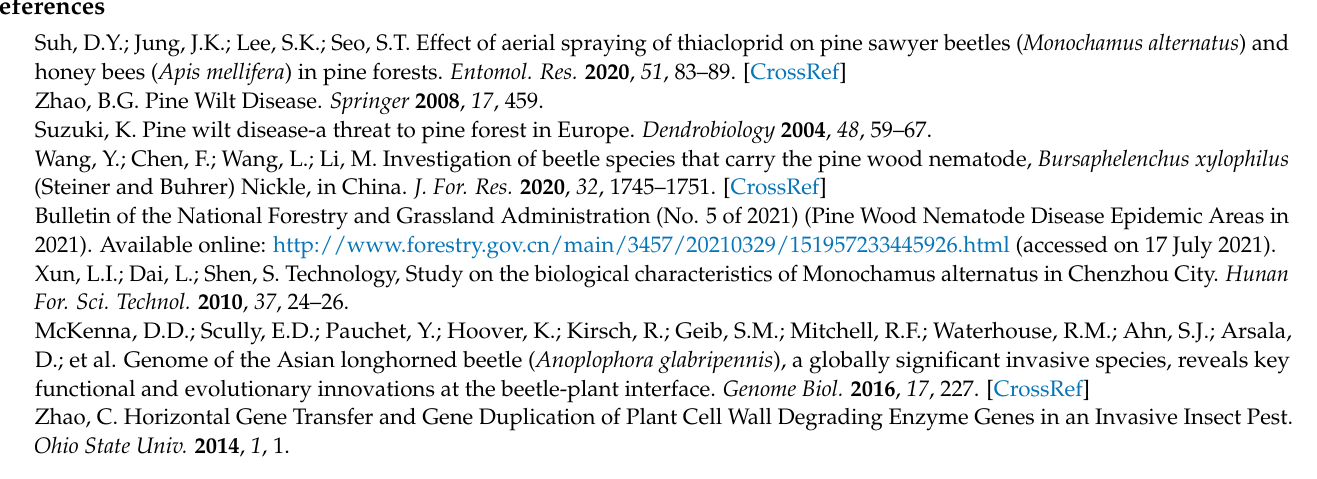
Heat map of chymotrypsin gene